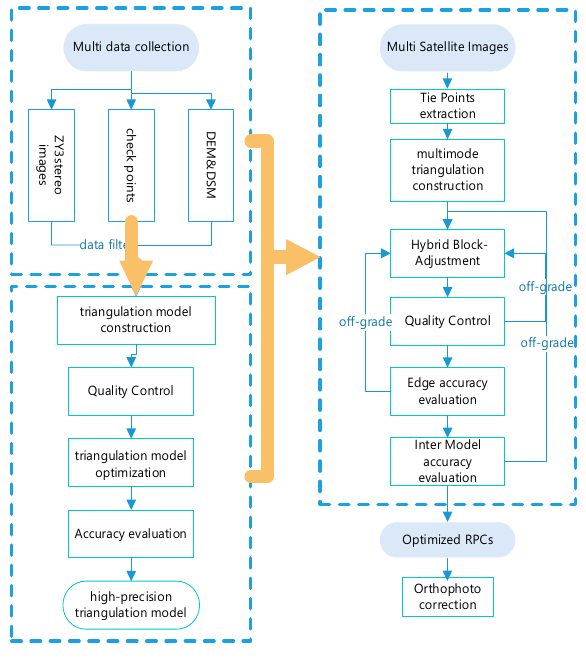
Figure 2. Main technical flow chart